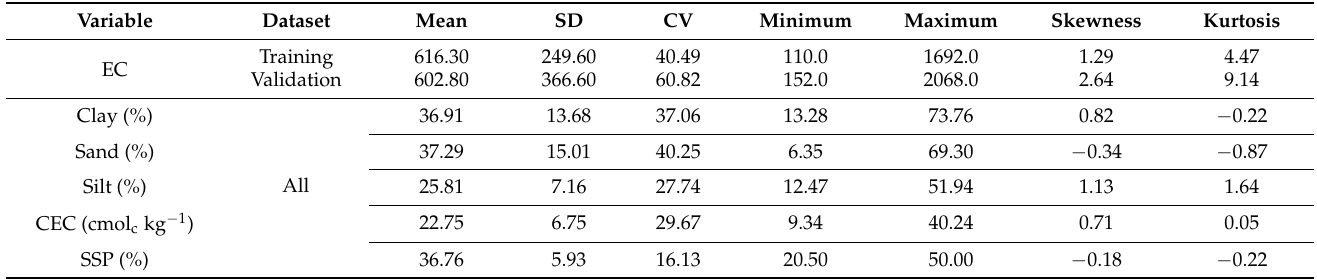
Table 2. Descriptive statistics of EC and some physical and chemical soil